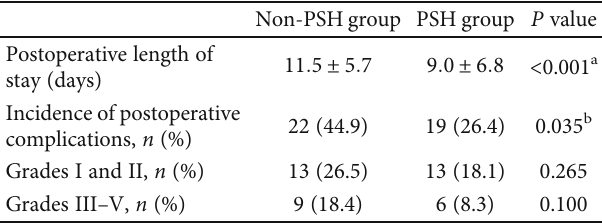
Table 4: Postoperative recovery status between non-PSH and PSH